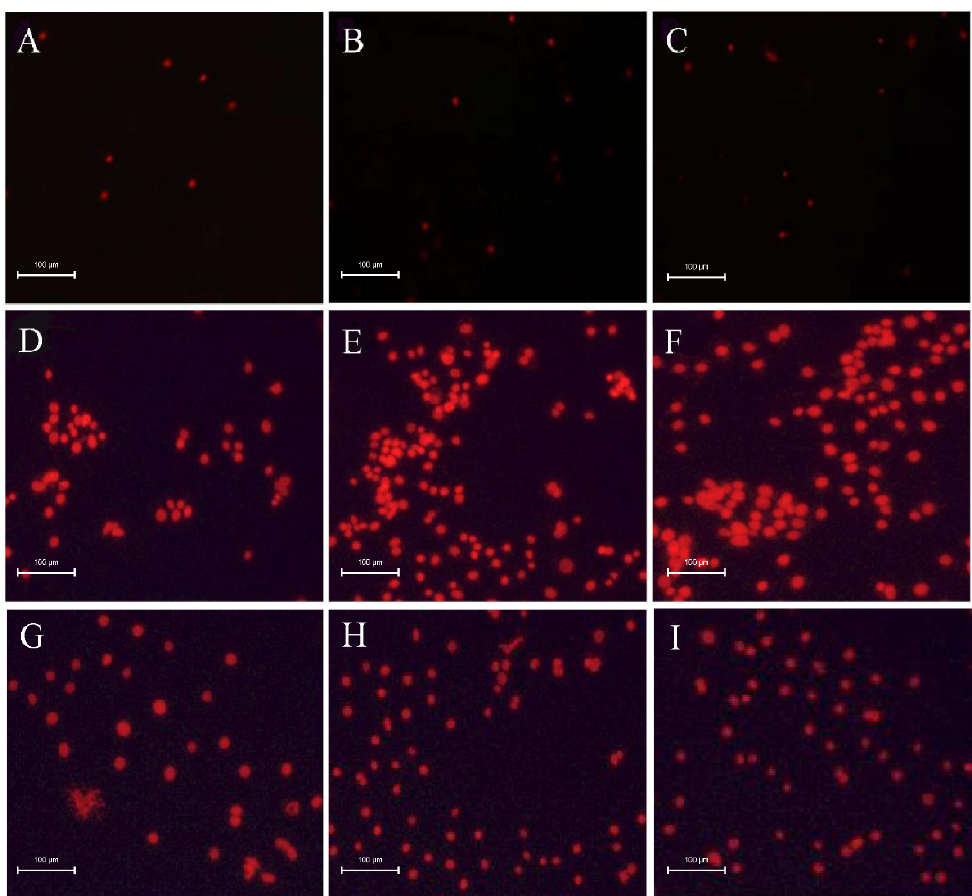
Figure 6. Membrane permeability of SL-1 cells over 72 h after treatment with rotenone at 0.2 and 20 µg/mL. Control: ( A ) 24 h, ( B ) 48 h, and ( C ) 72 h; 0.2 µg/mL of rotenone: ( D ) 24 h, ( E ) 48 h, and ( F ) 72 h; 20 µg/mL of rotenone: ( G ) 24 h, ( H ) 48 h, and ( I ) 72 h.